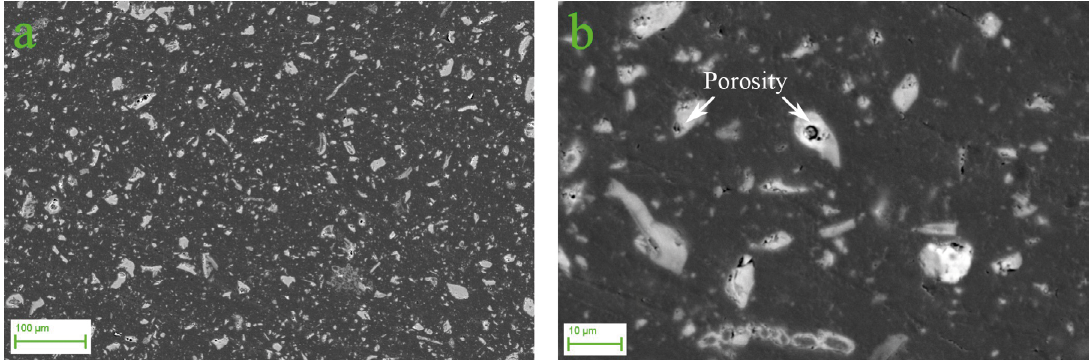
Figure 12. SEM microphotograph of a sample containing 20% (wt) RHA-FB Bars: A - 100 µm; B - 10